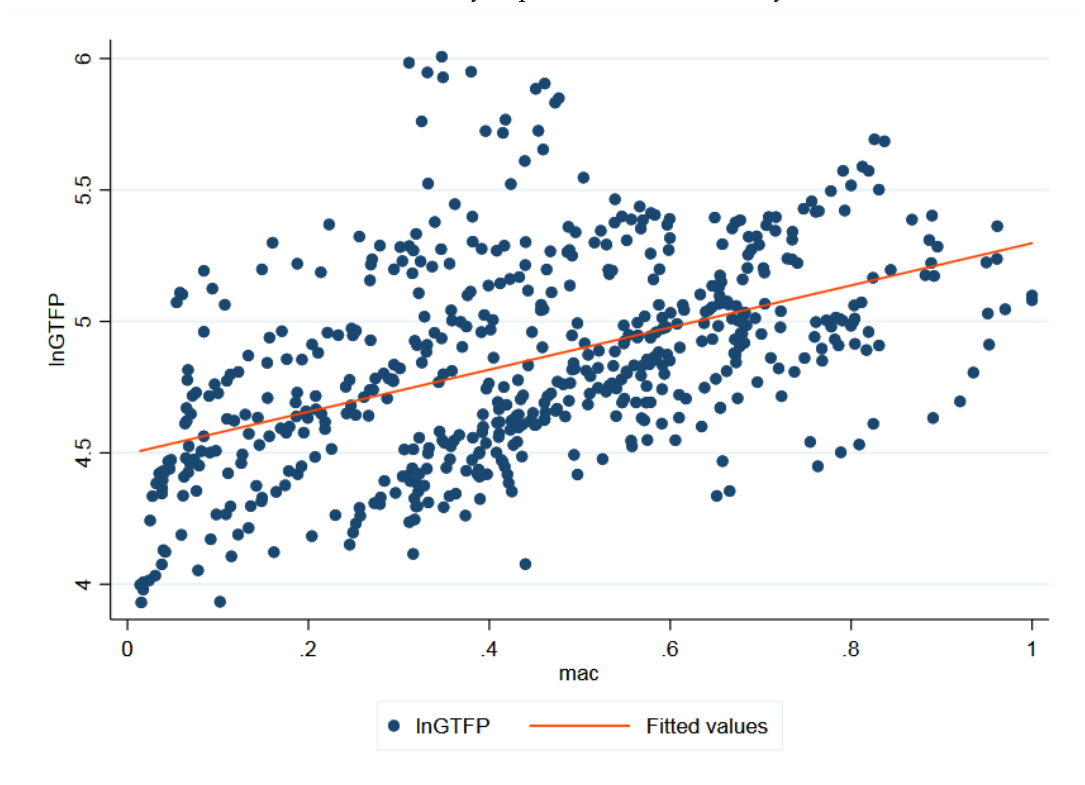
Figure 5. The binary relationship between mechanization and lnGTFP.